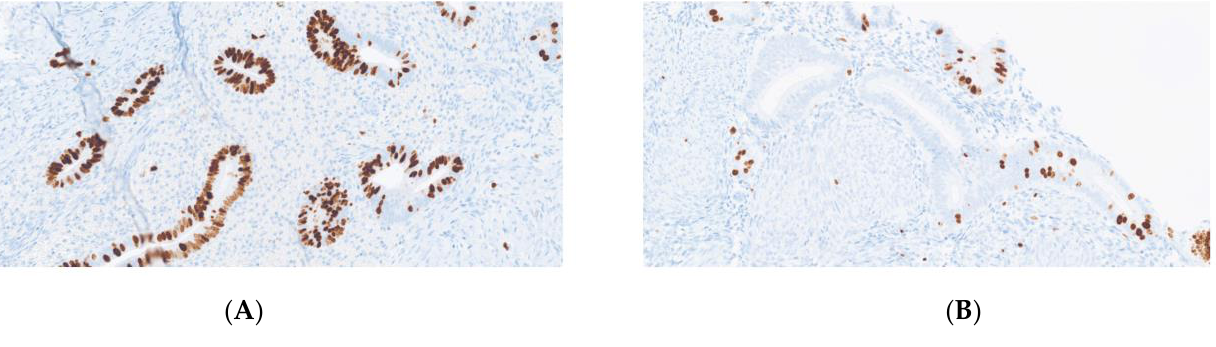
Figure 3. Immunohistochemistry for K67 (MiB1), demonstrating higher proliferative index in endo- metriosis than in the uterine remnant (×200). ( A ) endometriosis. ( B ) uterus remnant. Comparison of uterine endometrium and endometriotic specimen in healthy patients. Patient in proliferative phase (Figures 4 – 6).